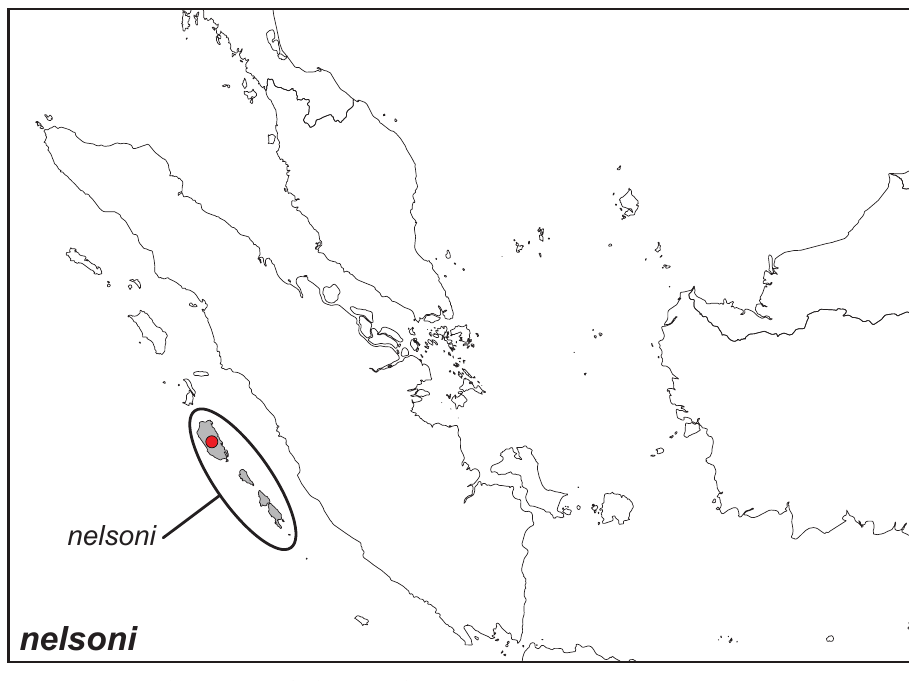
Figure 57. Distribution map of Elymnias nelsoni .